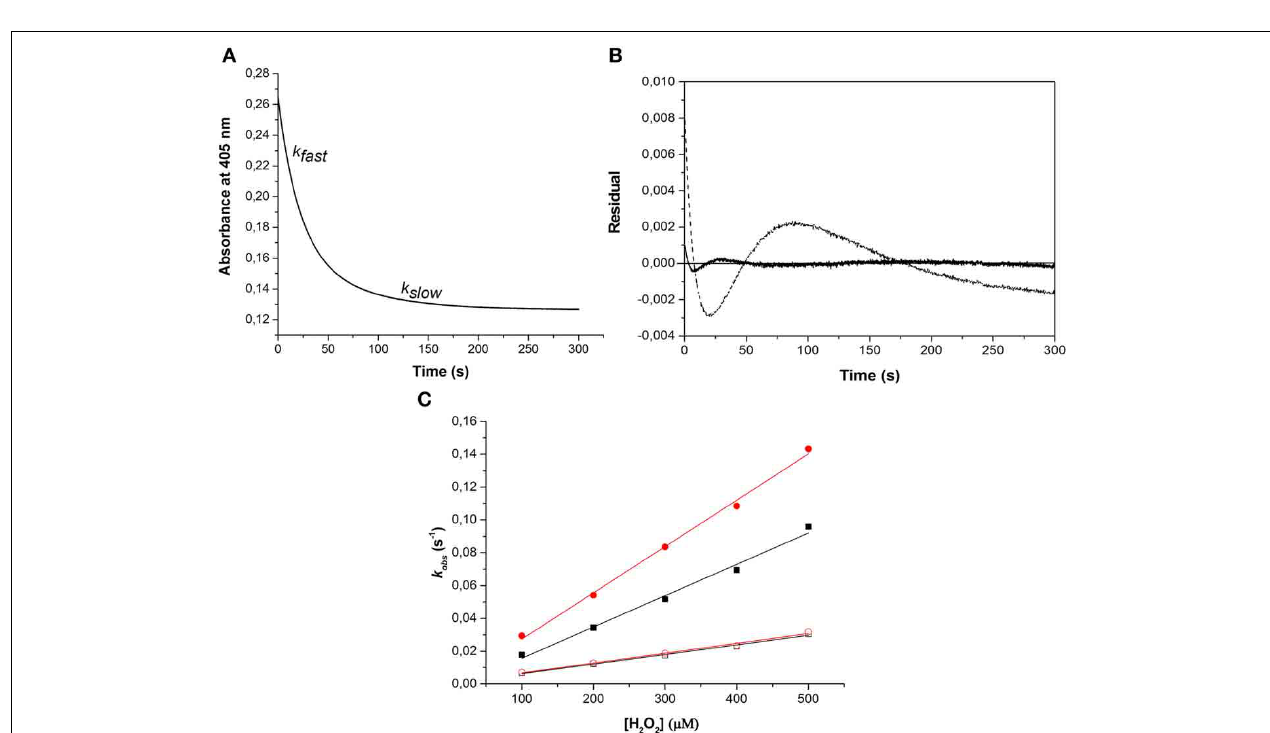
FIGURE 2 | Oxidation of ferric hemoglobin by hydrogen peroxide. The experiment was carried out under pseudo first order reaction conditions, where the concentration of Hb was kept constant at 10 μ M while varying the concentration of H 2 O 2 (100–500 μ M). (A) Represents an example of the time course for the reaction using 10 μ M ferric HbA and 500 μ M hydrogen peroxide monitored at 405nm. The time course was best fitted